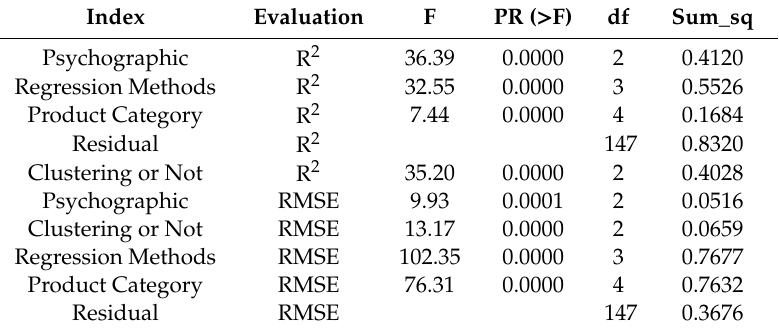
Table 5. ANOVA results for experimental settings in predicting consumer rating.